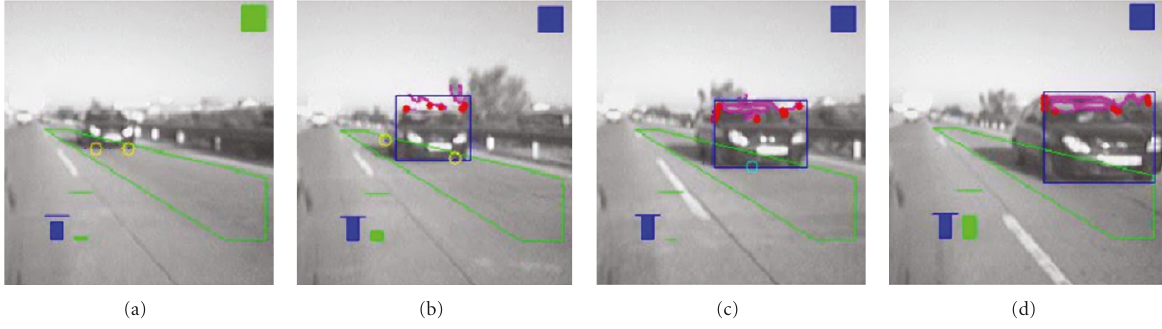
Figure 7: Example of the side-vehicle detection module (also called blind spot detection) in a sequence of images. The indicator in the upper-right part of the figure toggles from green to blue when a car is detected in the blind spot.